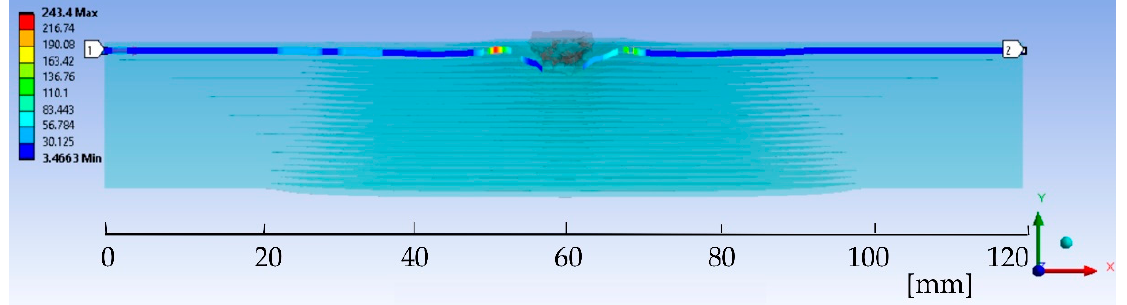
Figure 4. Detail of von Mises stress distribution for layer 2 and notations for analyzed length (stresses are given in MPa).